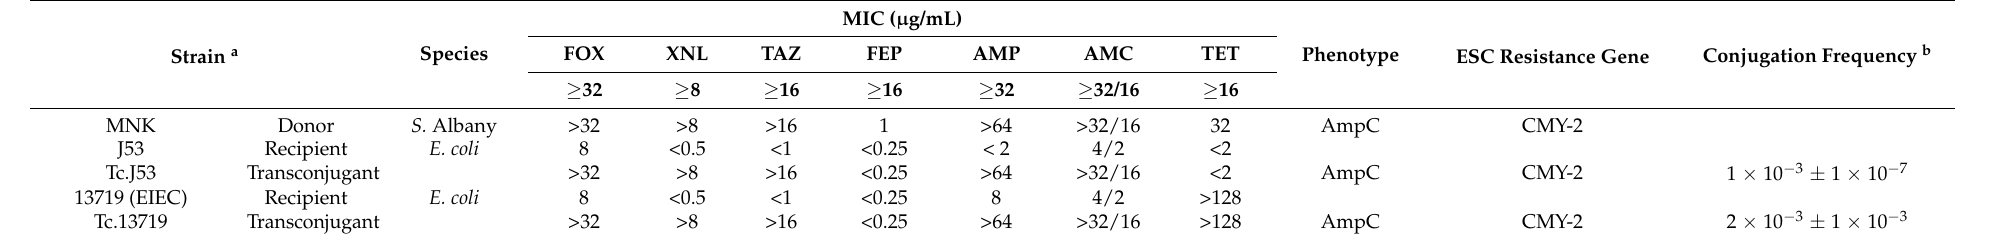
Table 2. Characteristic changes of transconjugant after conjugation and transfer frequency of the resistance